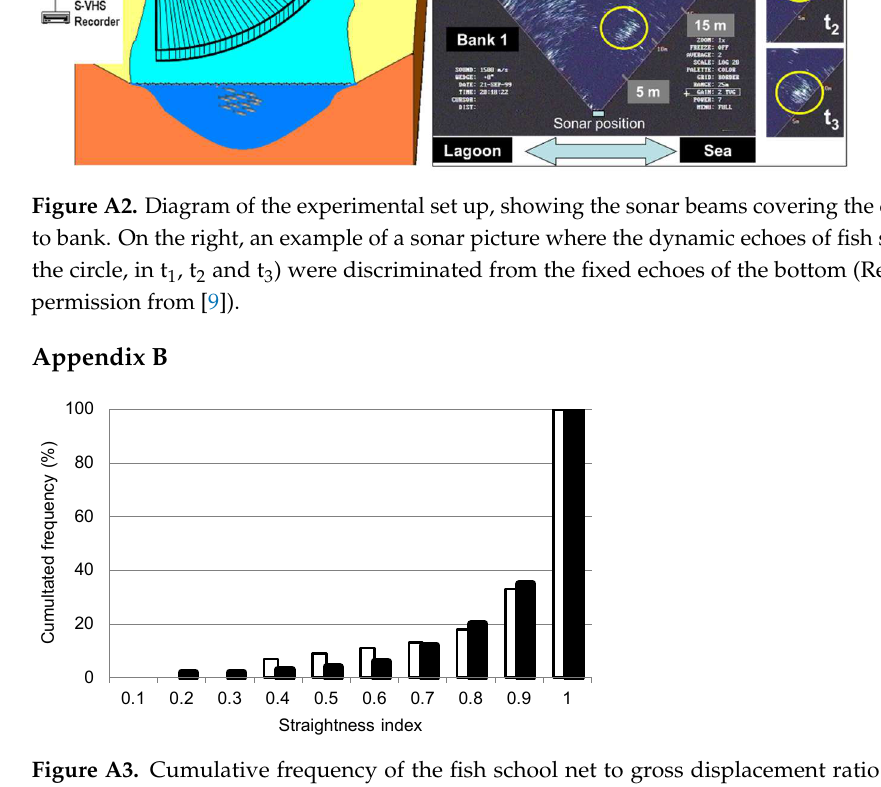
Figure A3. Cumulative frequency of the fish school net to gross displacement ratio ‘straightness index’; the schools having a SI above 0.9 (~65% of the schools) were considered to exhibit an oriented swimming behavior that corresponds to a certain form of active migration. In white, the Ingril lagoon schools, and in black the Prevost ones.